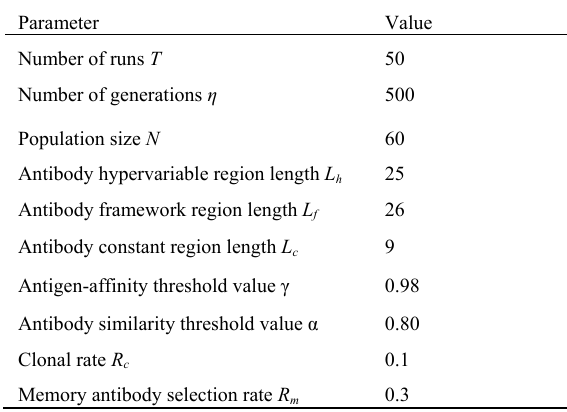
Table 2. The antibody evolution parameters.